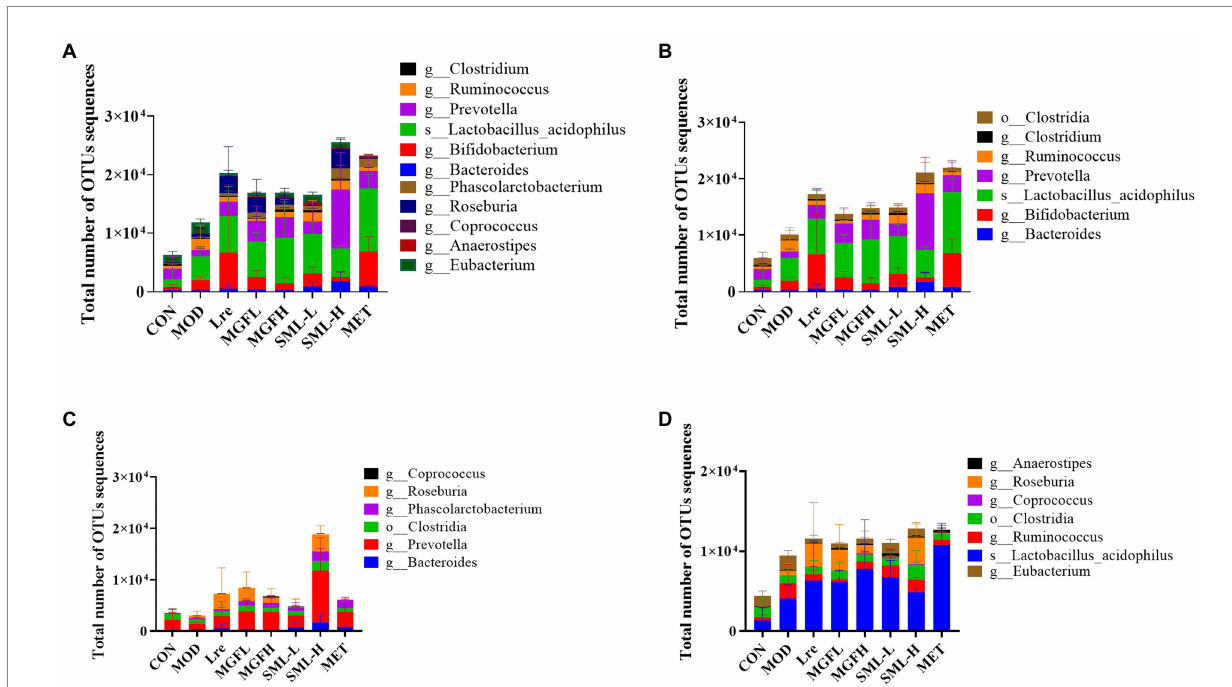
FIGURE 7 Total number of OTUs sequences statistics of SCFA-producing bacteria (A–D) were the results of SCFA-producing bacteria, acetic acid-producing bacteria, propionic acid-producing bacteria, and butyric acid-producing bacteria in the intestines, respectively.